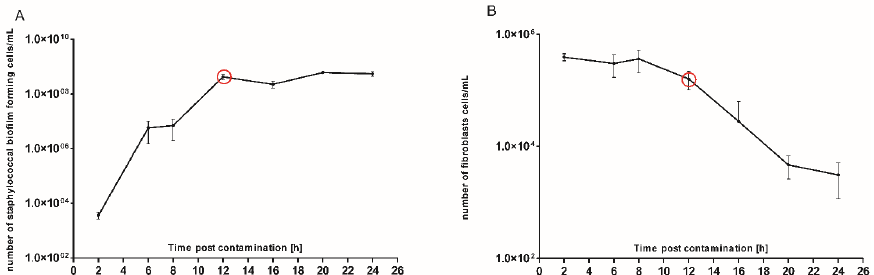
Figure 4. Co-culture of biofilm-forming S. aureus with L929 cells. ( A ) growth dynamics of bacterial biofilm; ( B ) alterations of fibroblast cell number. Red circles indicate the moment [12th h] of reaching a growth plateau by staphylococcal biofilm and co-current drop in fibroblast cell number.